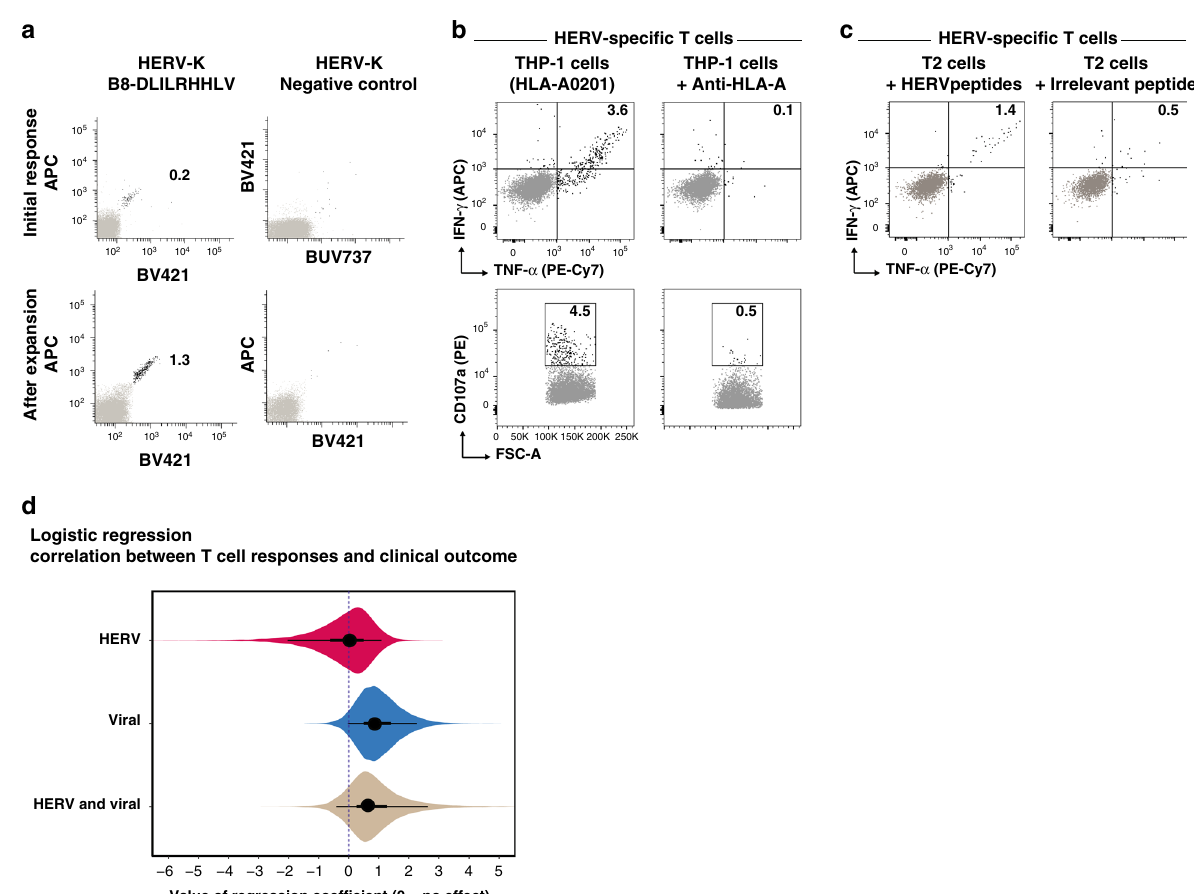
−6 −5 −4 −3 −2 −1 0 1 2 3 4 5